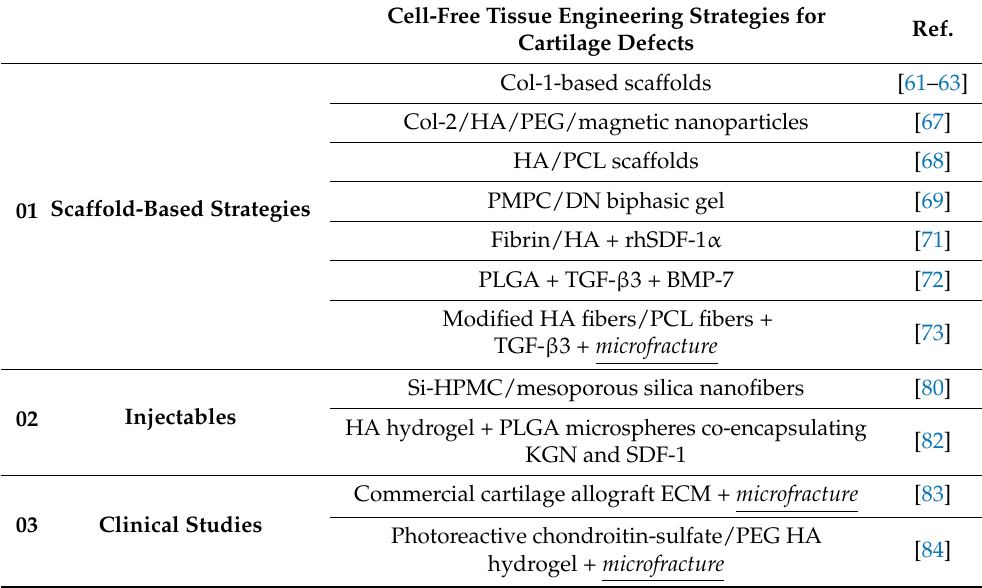
Table 3. List of studies on cell-free tissue engineering strategies for cartilage defects.